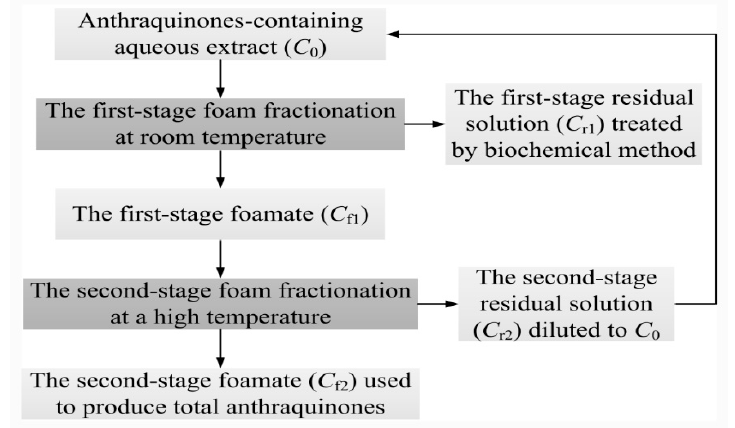
Scheme 1. Schematic diagram of the two-stage foam fractionation technology for separating total anthraquinones from their aqueous extract.